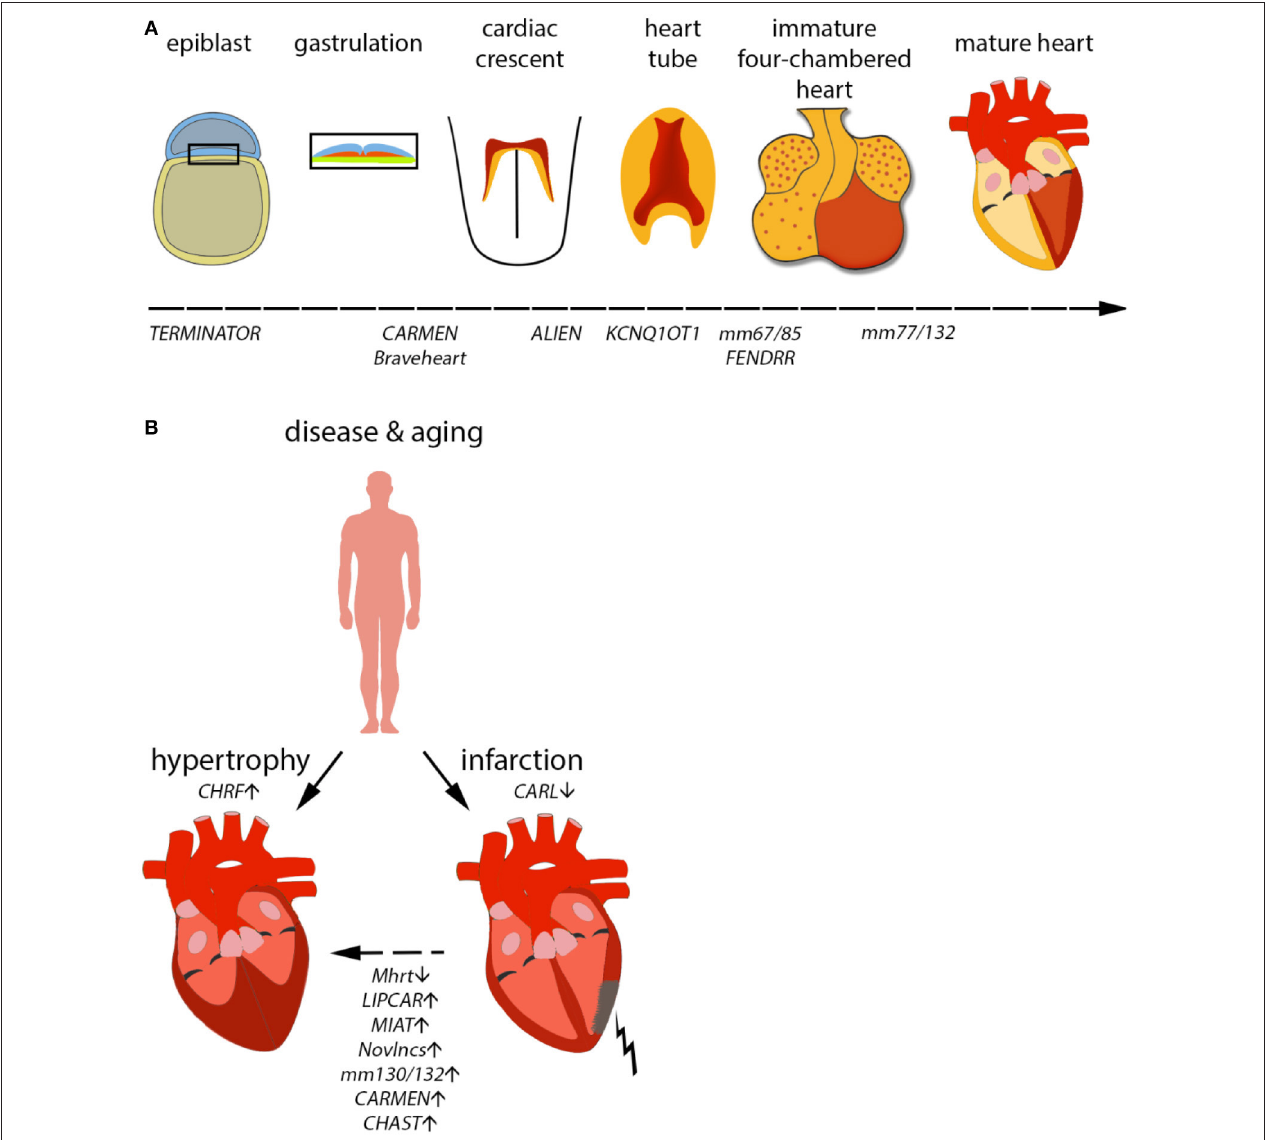
FIGURE 2 | Mammalian cardiac development in vivo/in vitro and consequences of aging on the heart. (A) Development of the mammalian heart is a complex series of events, marked by distinct morphological changes. Expression of selected lncRNAs is indicated along the developmental timeline. (B) During aging, the heart becomes hypertrophic, i.e., the heart muscle increases by an increase in cell size, not number. Furthermore, the risk of myocardial infarction (MI) increases with age. MI can eventually result in hypertrophy in order to compensate for the loss in heart muscle. Selected lncRNAs identified to play a role in infarction or hypertrophy are